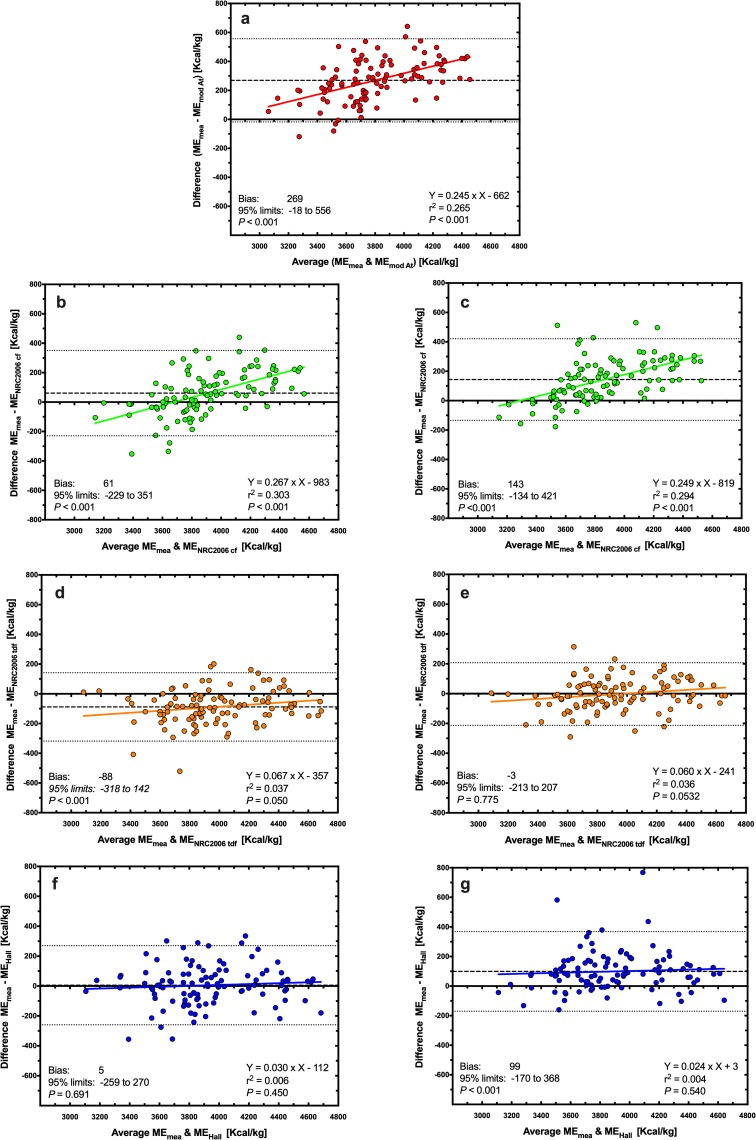
Bland-Altman plot depicting the relationship between measured and predicted metabolisable energy (ME) content in dry feline diets.The y- and x-axes depict the difference between and the average of the measured and predicted ME content of dry feline diets, respectively. The points represent results for individual foods, the dashed back line depicts the average bias, the dotted black lines depict the 95% confidence limits to the agreement, and the solid coloured line represents the trendline from linear regression analysis. Different figures represent predictions made with MA (red, a), NRC 2006cf (green; b: predicted GE; c: measured GE), NRC 2006tdf (orange; d: predicted GE; e: measured GE), and Hall equations (blue; f: predicted GE; g: measured GE).